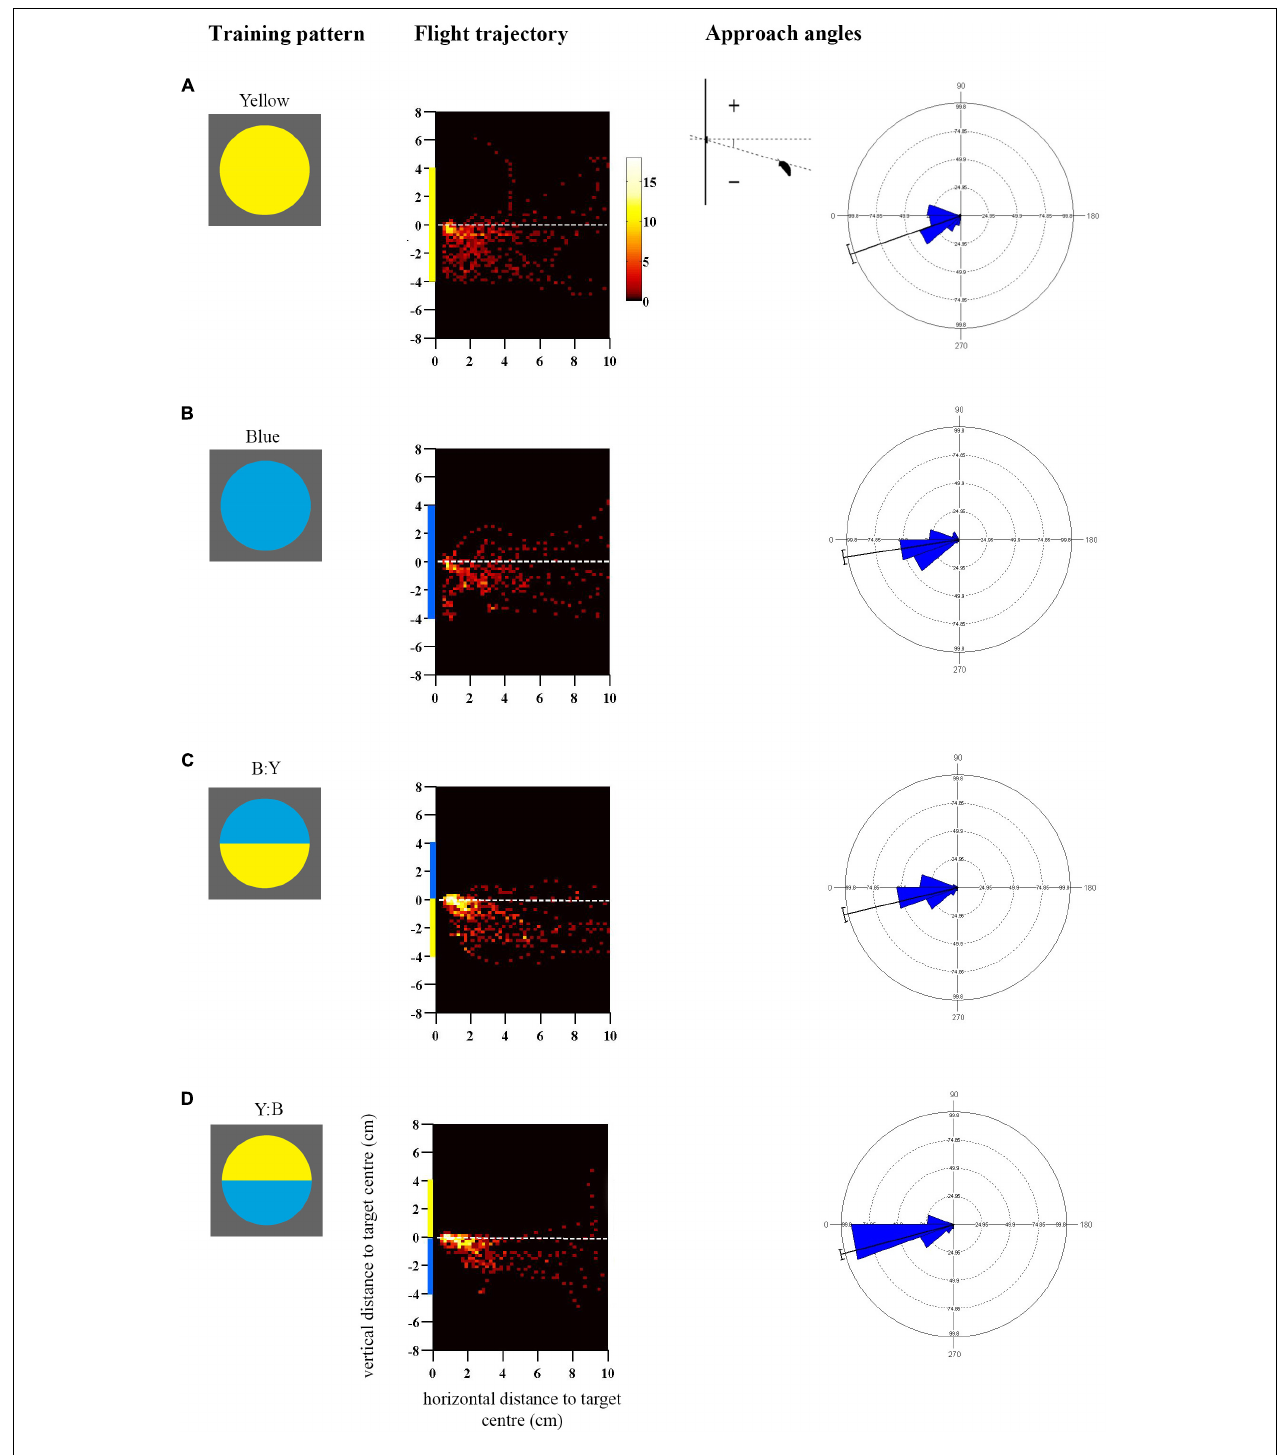
FIGURE 1 | Approach flights of bumblebees trained to collect sucrose from the centre of a vertically presented coloured disc, over a distance to the target from 10 to 0.5 cm. Training patterns were single-colour (A) Yellow or (B) Blue discs, or bicolour (C) B:Y or (D) Y:B patterns with a central contrast line, presented on a grey background. Heat-map plots depict the video capture area (filmed from the side) divided into 0.04 cm2 pixels denoting the frequency of positions of bees during the last training flight prior to tests (see colour scale next to A ) ( N = 10 bees for (A,B) ; (C) N = 11 bees and (D) N = 12 bees). X -axis depicts horizontal distance and Y -axis vertical distance to the target plane. Approach angles are shown on the right (see inset). Angles between 0 ◦ and 270 ◦ indicate a position below the contrast-line, and angles between 0 ◦ and 90 ◦ above the contrast line.